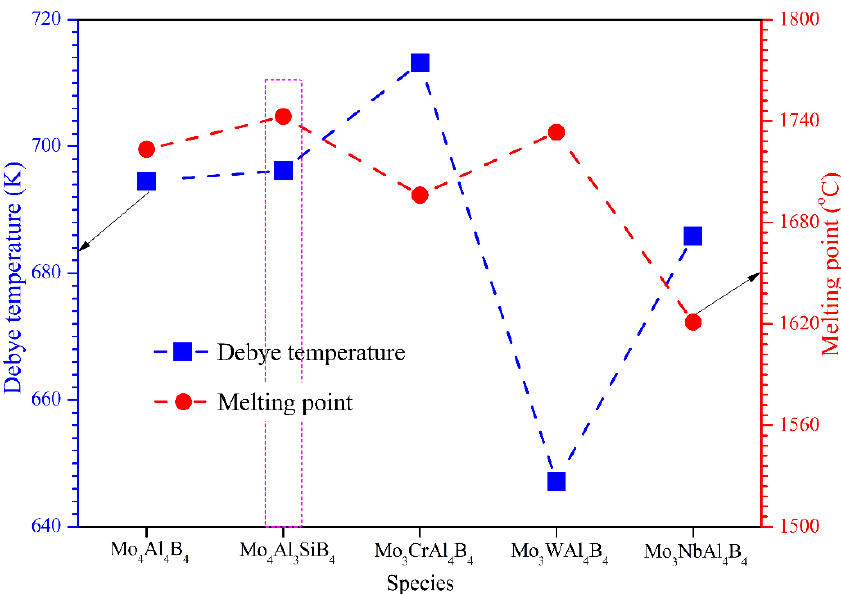
Figure 7. Debye temperature and melting point.